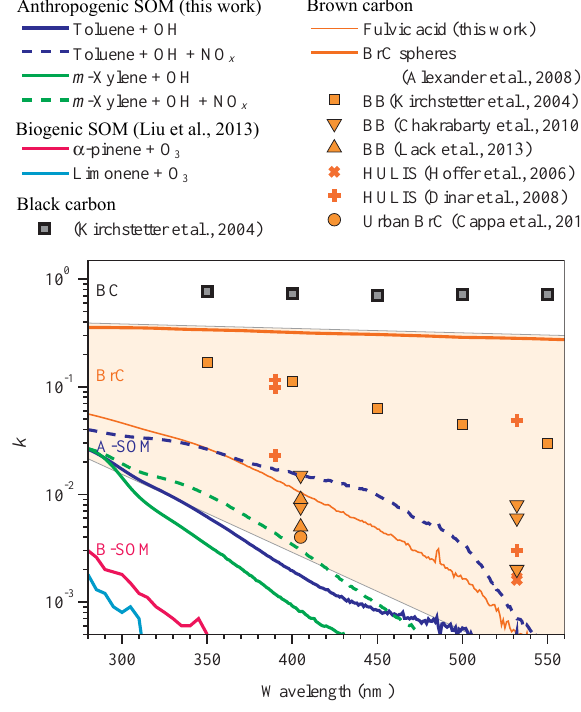
Figure 4. Comparison of wavelength-dependent k values for dif- ferent types of atmospherically relevant light-absorbing materi- als. This study: anthropogenic SOMs (A-SOM) derived from re- acting toluene or m -xylene at low NO x (NO 0 = 0ppm) and high NO x (NO 0 = 10ppm; HC 0 / NO 0 = 3 . 5 and 4.0ppbC ppbN − 1 for toluene and m -xylene, respectively), and a brown carbon (BrC) surrogate (Suwannee River fulvic acid). Literature: α -pinene- and limonene-derived biogenic SOMs (B-SOM), various atmospheric BrC in both biomass burning (BB) and urban plumes, and black carbon